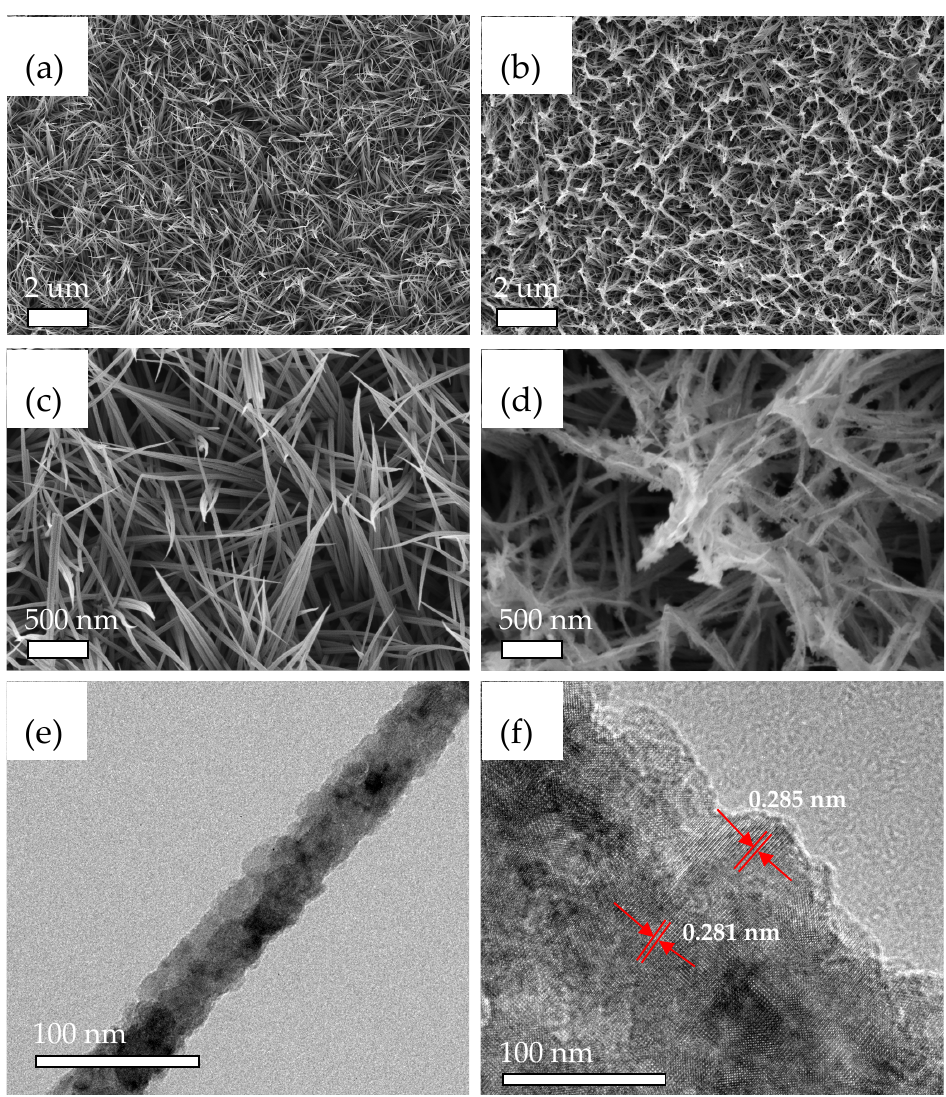
Figure 3. ( a , b ) SEM images for NiCo 2 S 4 samples, ( c ) low magnification SEM images for NiCo 2 S 4 @NiMoO 4 , ( d ) high-magnification SEM images, ( e , f ) TEM images for NiCo 2 S 4 @NiMoO 4 samples.